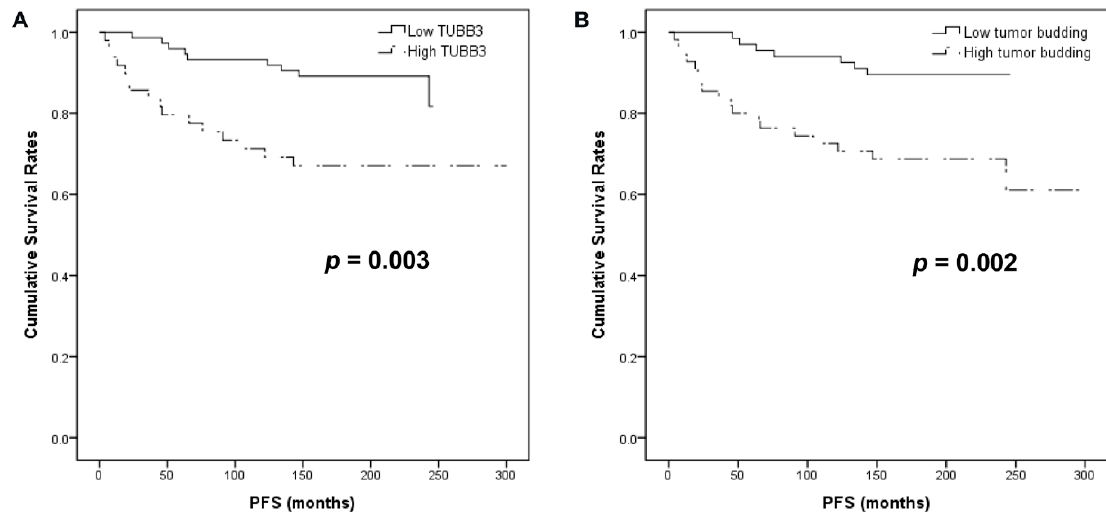
Figure 6. Kaplan–Meier analysis of patients based on TUBB3 H-score and tumor budding. ( A )